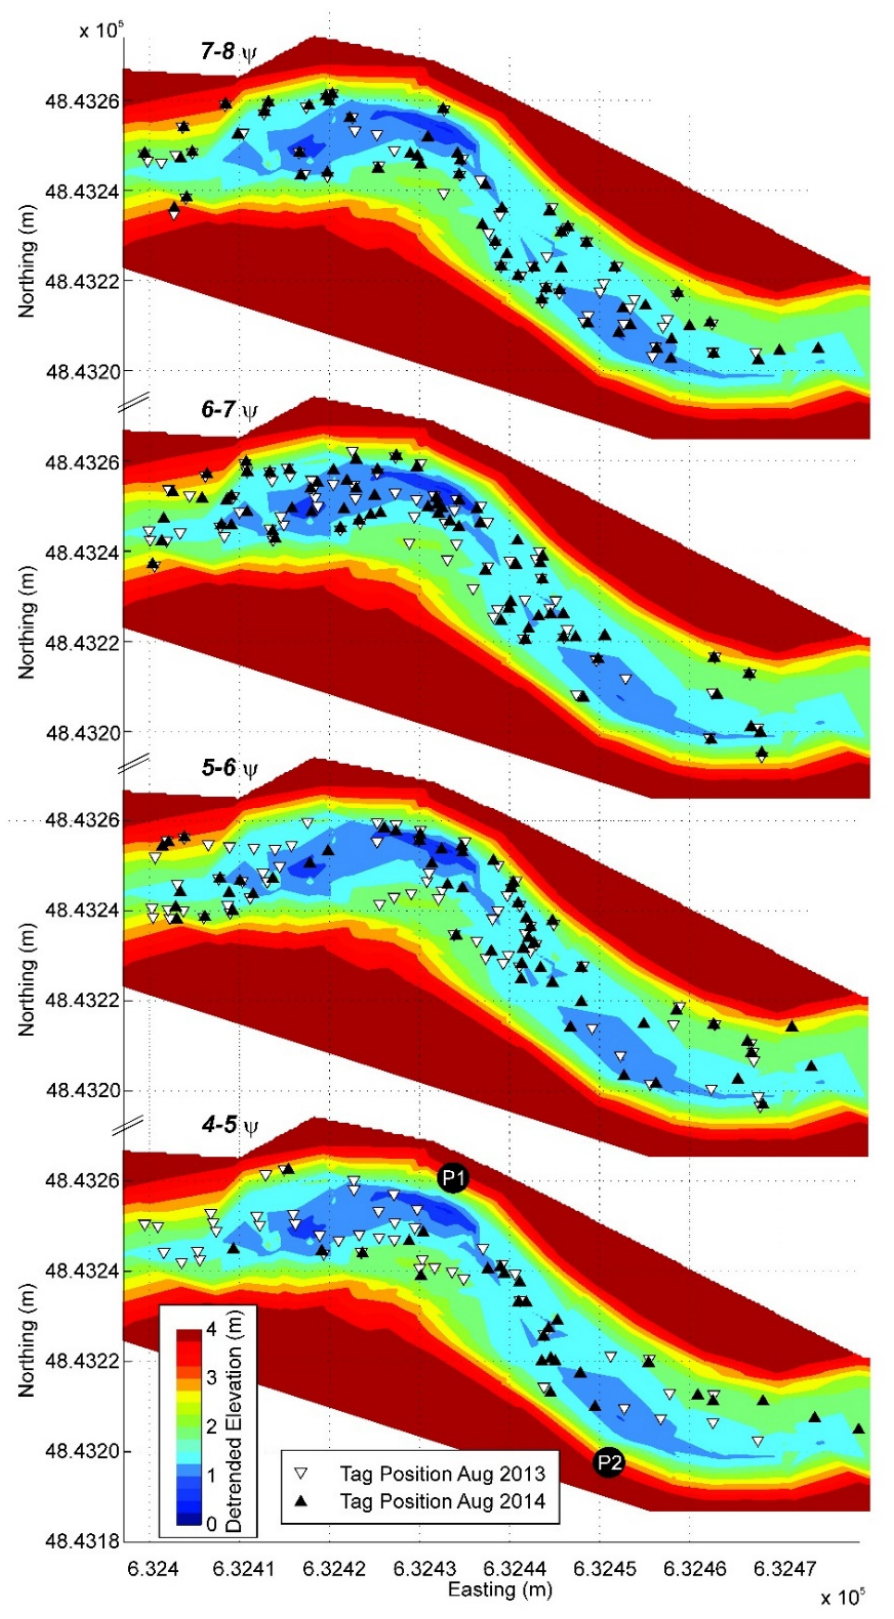
Figure 8. Entrainment and deposition over 1 year of tracking shown at morphologic sub-unit scale. The elevation has been detrended by subtracting the overall slope of the channel. Pools are numbered to facilitate the description of the